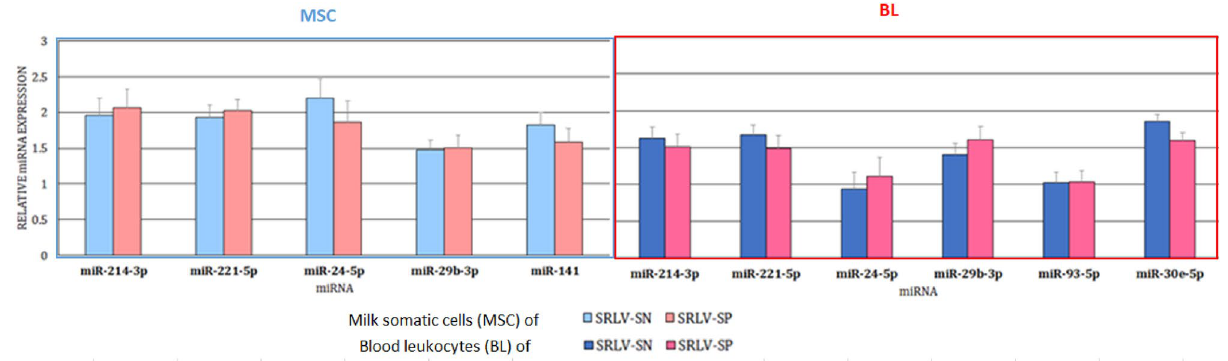
Figure 2. Comparison of the miRNA levels (LSMEANS, ± SE) between SRLV-seronegative and SRLV- seropositive goats in their milk somatic cells or blood leukocytes. SRLV-SN small ruminant lentivirus seronegative goats, SRLV-SP small ruminant lentivirus seropositive SRLV-SN goats, miR-93-3p expression was higher on day 1 of lactation, i.e. immediately after kidding, and on day 60 at the peak of lactation, compared to day 30, i.e. early in lactation; however, no expression was observed on day 200 (late lactation). In contrast, miR-30e-5p expression peaked on day 1 of lactation compared to day 60 in both groups of animals; however, no transcripts were found during mid-lactation or late lactation. A functional